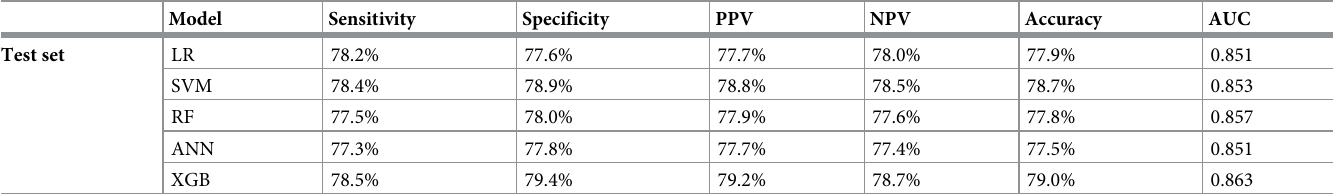
Table 4. Confusion matrix for prediction models (Test set).